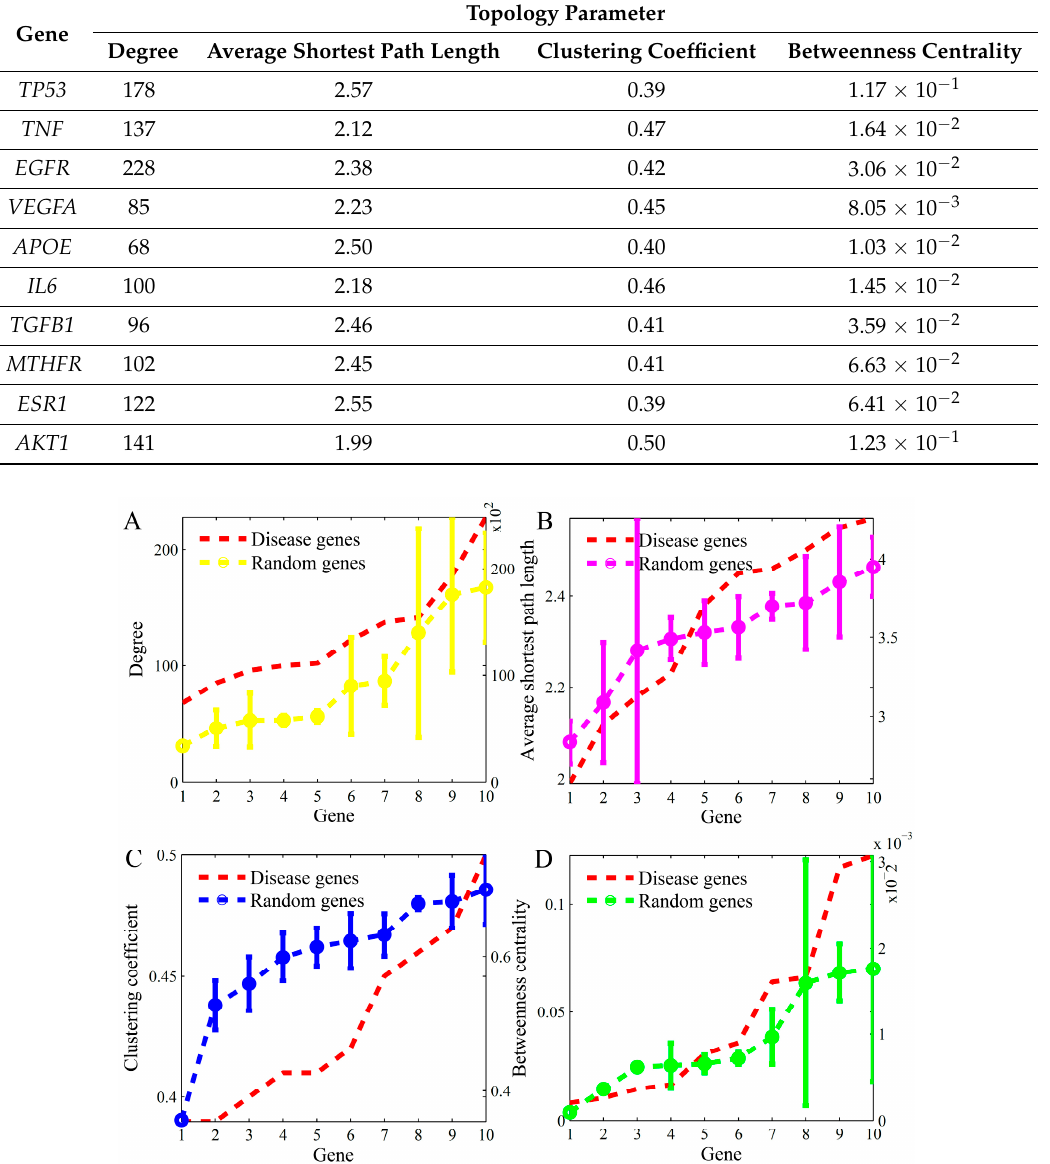
Figure 2. The comparisons of four topology parameters between disease genes and randomly-selected normal genes: ( A ) degree, ( B ) average shortest path length, ( C ) clustering coefficient, and ( D ) betweenness centrality. The x-axis is for ten genes, the left y-axis is for “mean” and the right y-axis is for “standard deviation”.